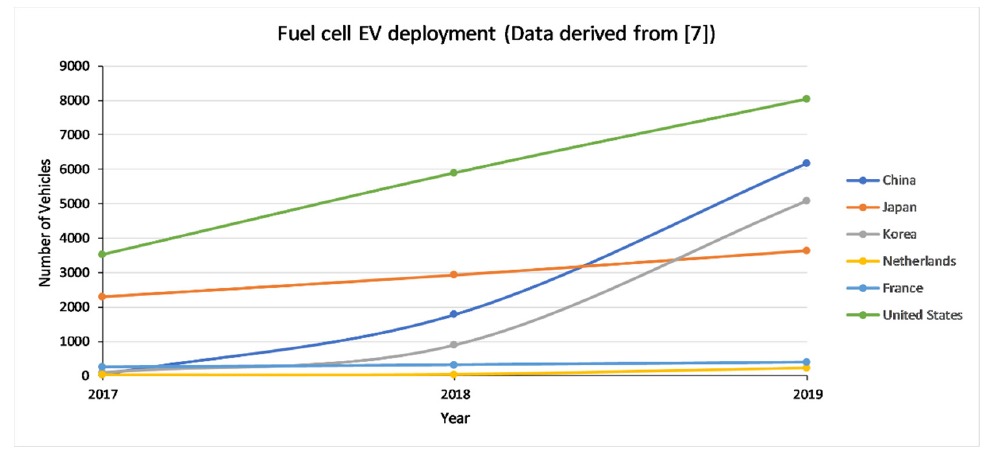
Figure 2. FCEVs around the world from 2017–2019 [7].